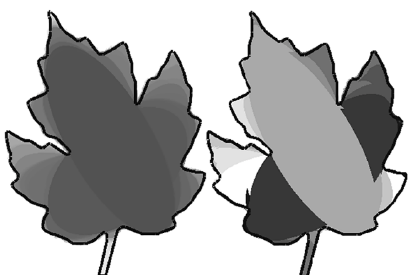
Figure 5: Elliptical thickness maps for arbitrary (not fixed) ellip- tical SE. It is possible to build them based on discrete-continuous morphological pattern spectrum algorithm for fixed elliptical SE, but to do it fairly effectively we need to use a finite set of allowed ellipse parameters.